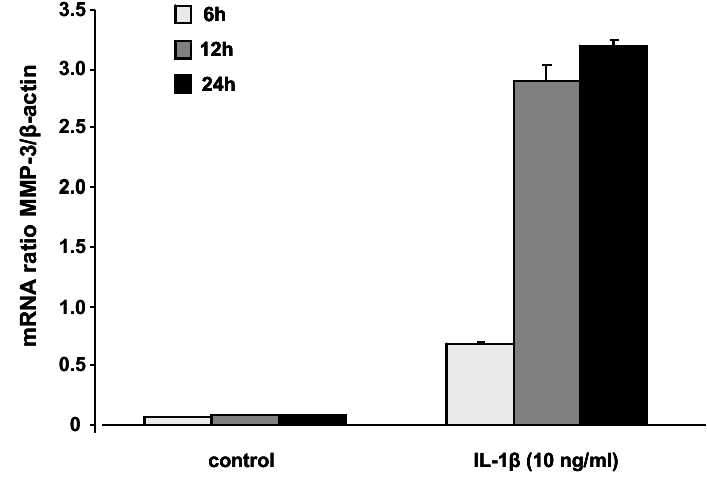
Figure 3. MMP3 mRNA levels in SW1353 cells following 6, 12, and 24 h of incubation with IL-1 β (10 ng/mL). The highest induction of MMP3 was observed after 24 h of incubation. Results are calculated in relation to β -actin and expressed as means + SEM of three independent experiments performed in